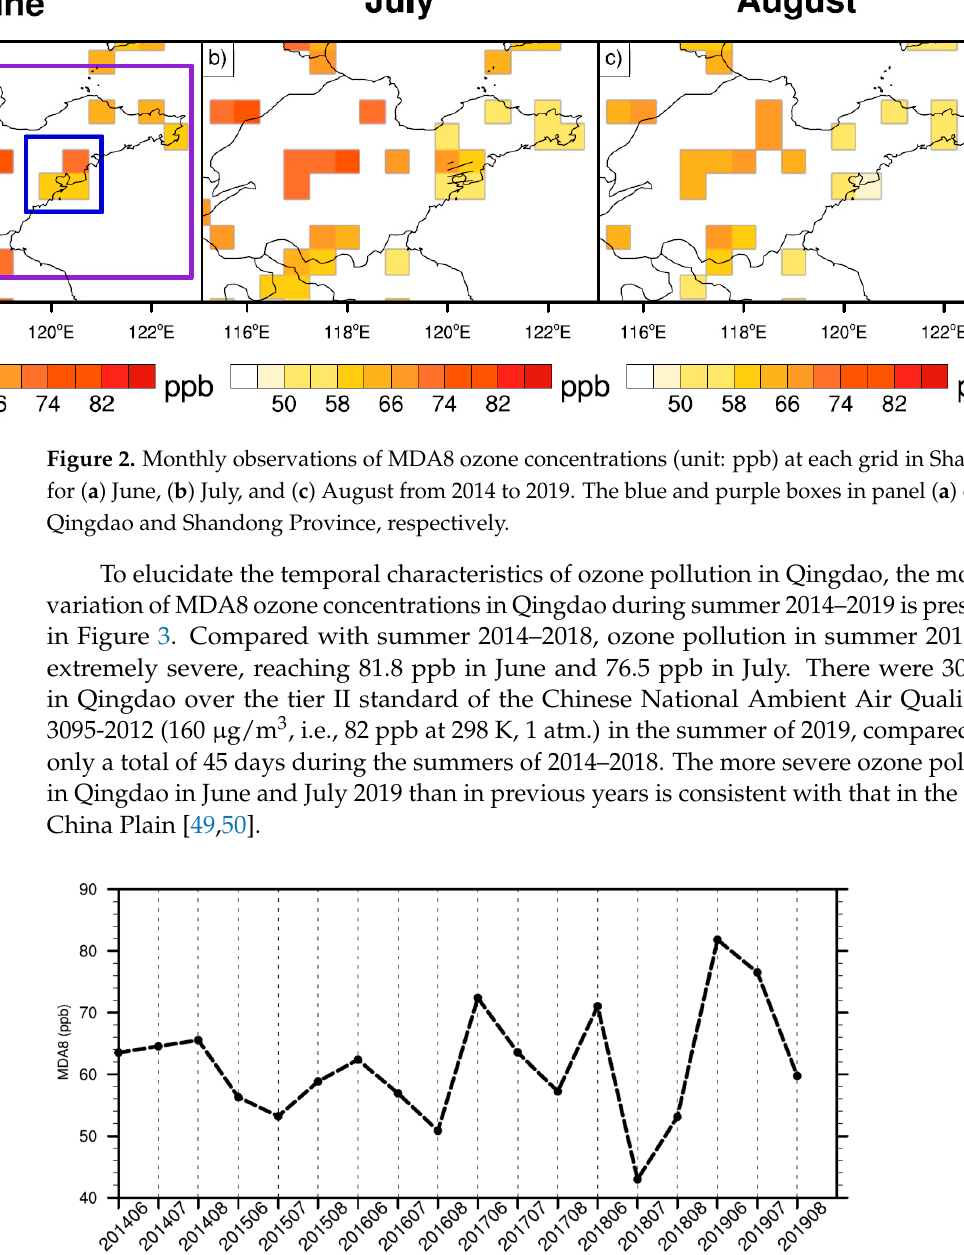
Figure 3. Monthly variations of observed MDA8 ozone concentrations (unit: ppb) in Qingdao during summer 2014–2019.